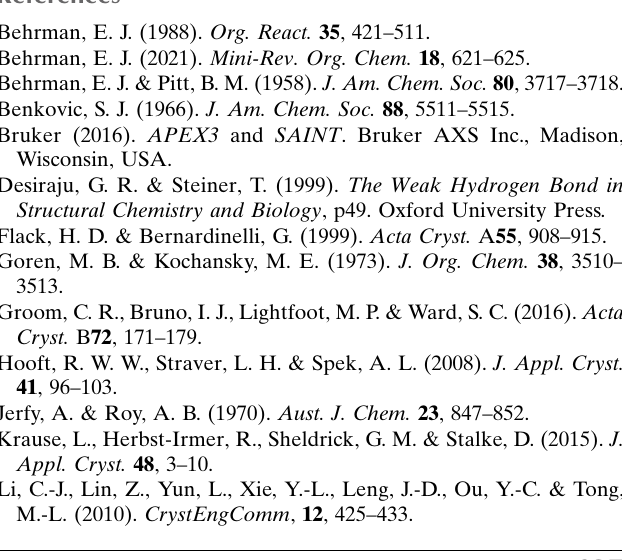
Crystal data Chemical